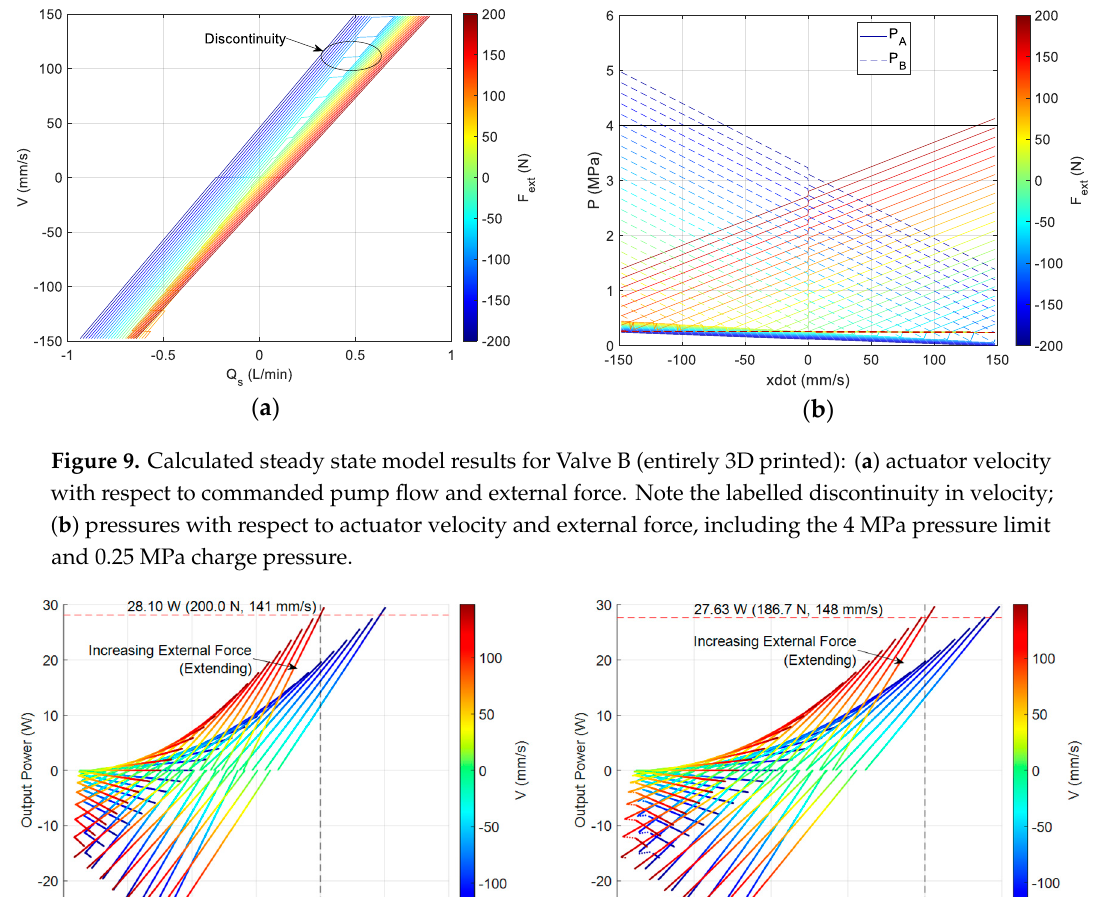
Figure 8. Calculated steady state model results for Valve A (steel sleeve and spool): ( a ) actuator velocity with respect to commanded pump flow and external force. Note the labelled discontinuity in velocity; ( b ) pressures with respect to actuator velocity and external force, including the 4 MPa pressure limit and 0.25 MPa charge pressure.